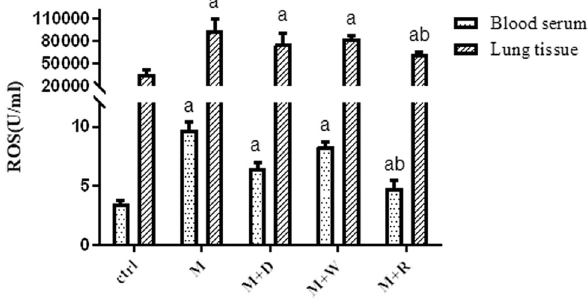
Figure 8: Analysis of the expression levels of oxidative stress pro - ducts in the serum and lung tissues of rats in each group: ( a ) sta - tistically signi fi cant di ff erence from the Ctrl group ( P < 0.05 ) and ( b ) statistically signi fi cant di ff erence from the M group ( P < 0.05 ) .